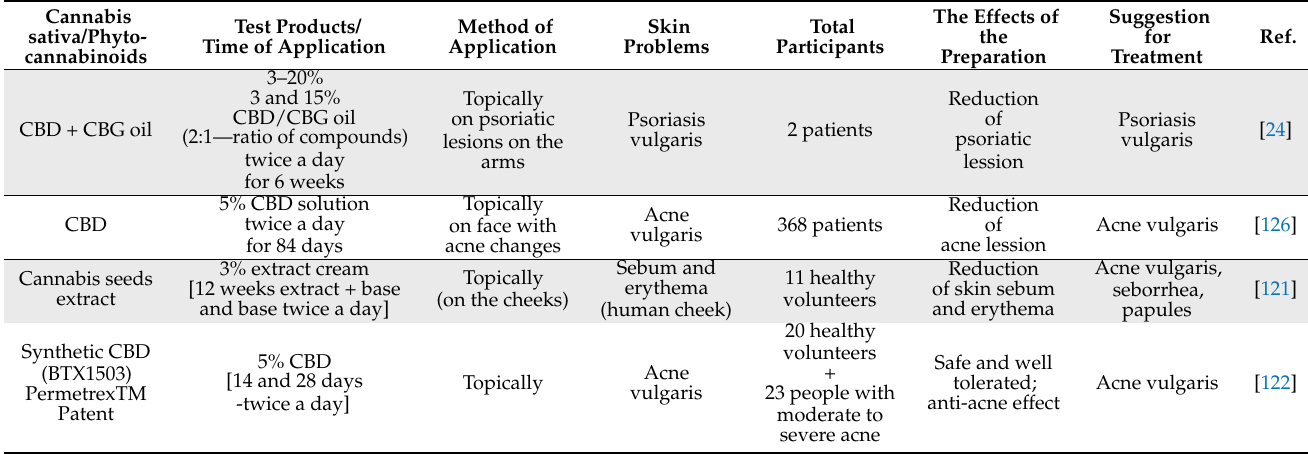
Table 3. The use of phytocannabinoids in clinical